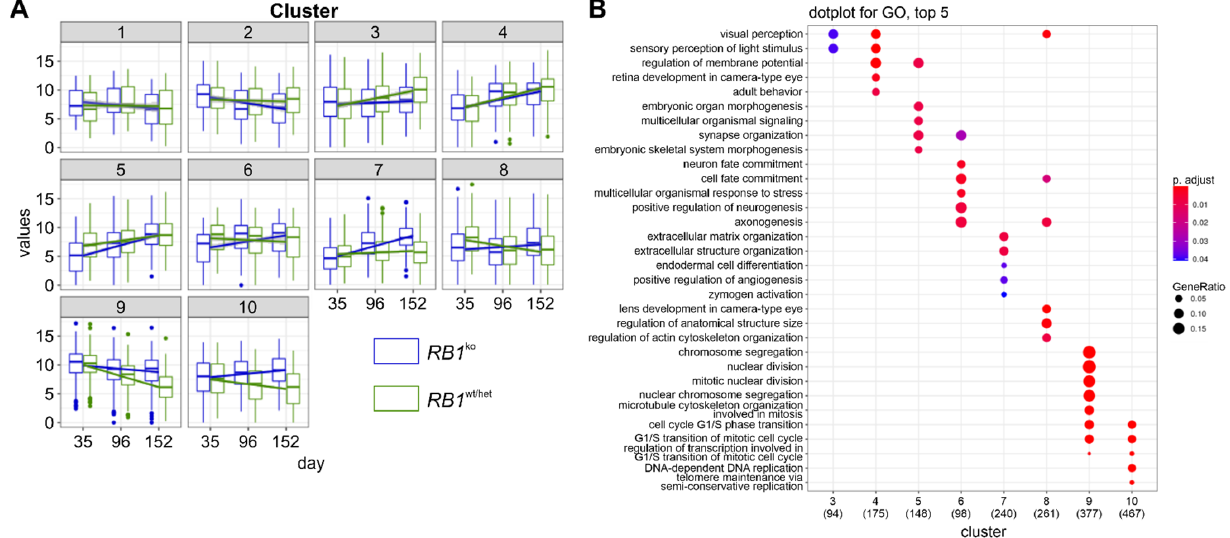
Figure 6. Multiparametric analysis of differential gene expression in retinal differentiation. ( A ) Multiparametric analysis considering genotype ( RB1 wt/het versus RB1 ko ), day of differentiation and batch effects of independent experiments. DEGs were filtered by p -adjust < 0.05 and log2FC > 1. Filtered DEGs were assigned to 10 clusters. Expression of genes in clusters over time is shown. ( B ) Top 5 ( p -adjust < 0.05) enriched biological processes per cluster determined by reduced redundancy GO analysis. The total number of DEGs in each cluster associated with a GO-term is given in parentheses, dot size: ratio of number of DEGs present in the specific GO-term versus total number of GO-term associated DEGs in this cluster, dot color: p -adjust. If any of the top 5 terms of one cluster is present in another cluster, corresponding dots are